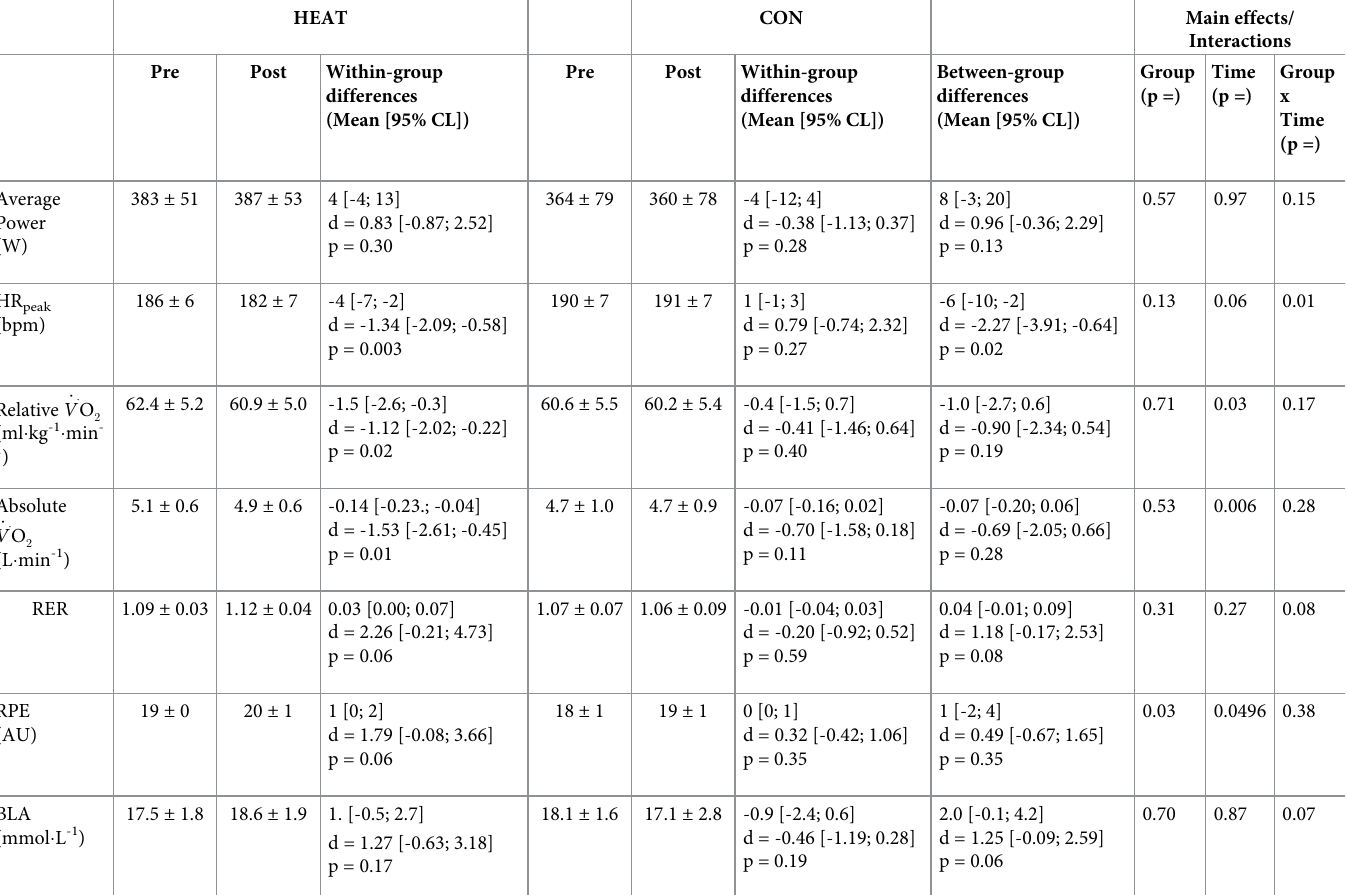
Table 3. Comparison of physiological and perceptual measures of national-level rowing athletes taken during a 4-min time trial, before (Pre) and after (Post) a 10-session heat acclimation intervention.